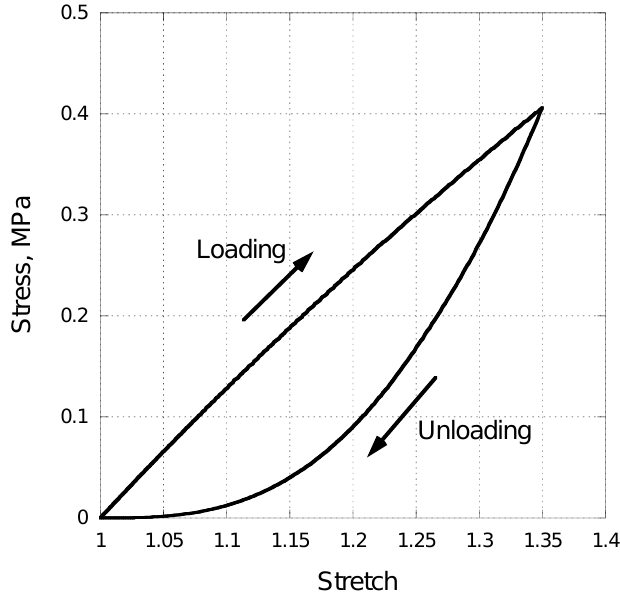
Figure 3. Stress-stretch relations under simple tension with hysteresis.